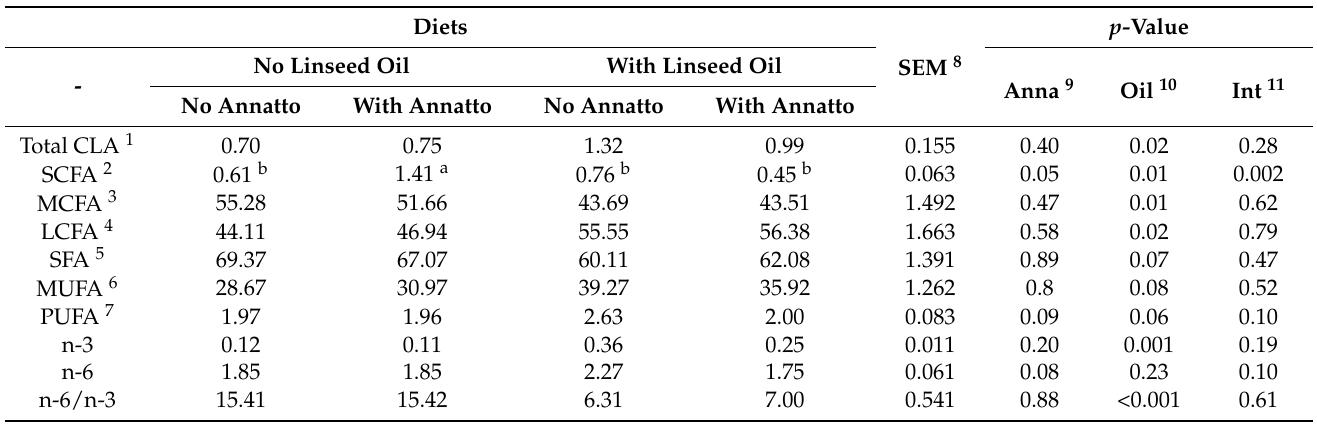
Table 5. Percentage concentrations and ratios of fatty acids grouped in the milk of Holstein cows fed annatto seeds and linseed oil.